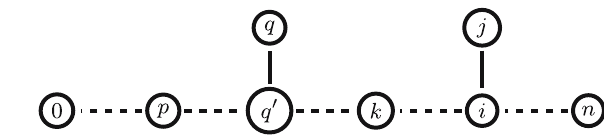
Figure 13: Minimum subgraph of C containing vertices { } p q j k n 0, , , , , , when < ≤ p n 0 and > q n